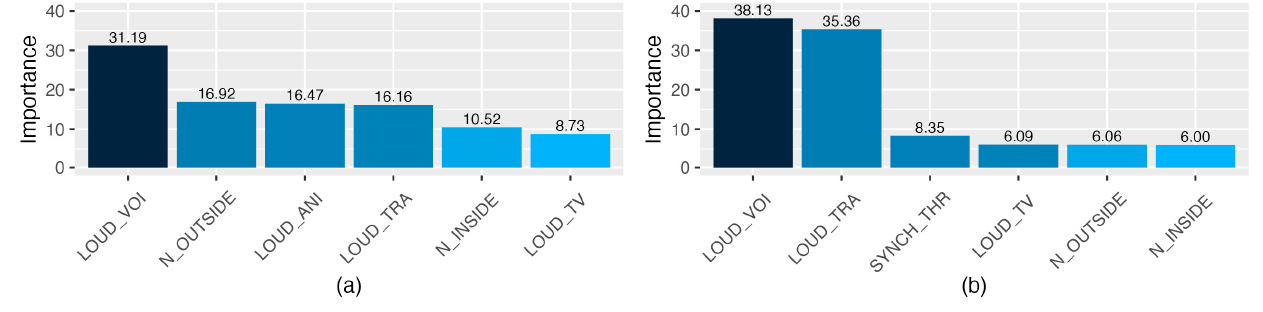
Figure 10. Percentage of the relative importance of the predictors of the ANNs on the noise interference with the synchronous activities calculated with the Olden et al. method [61], using as predictors the variables selected by mRMR ( b ) and the set of reduced Boruta variables ( a ). Values higher than zero mean a positive relative contribution, and those lower than zero mean a negative relative contribution.